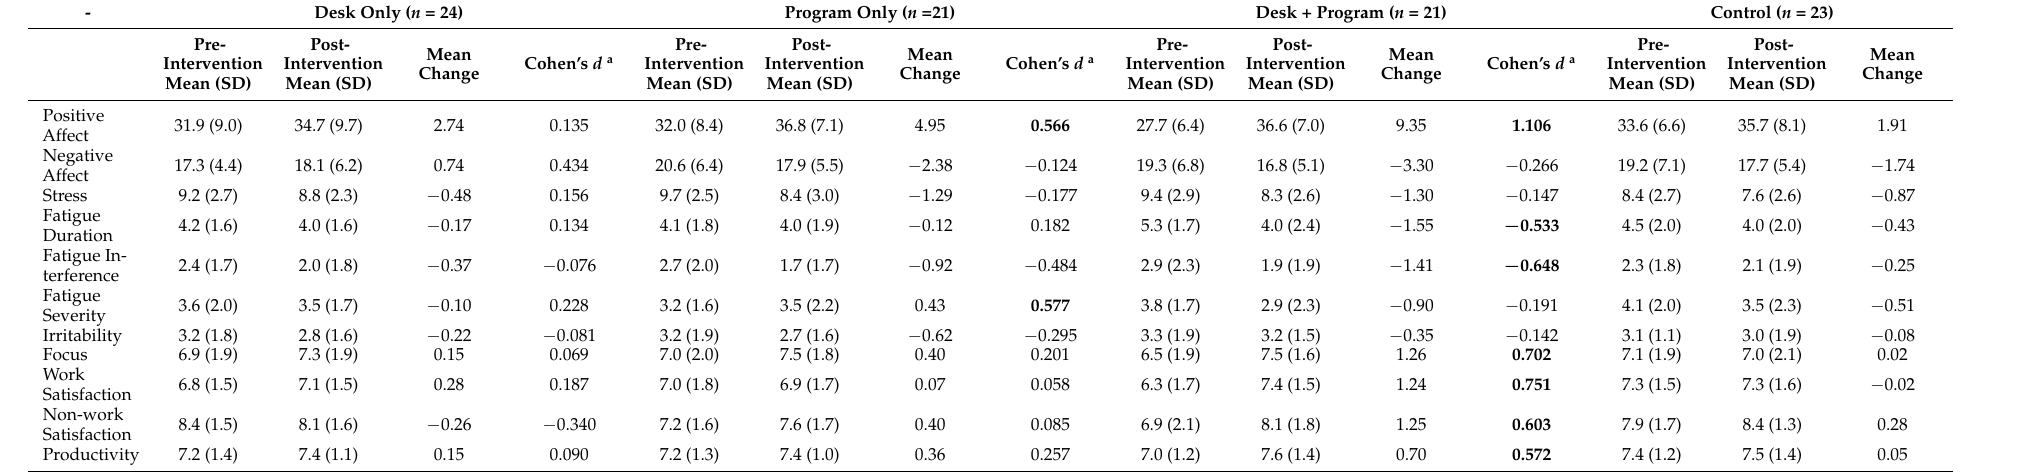
Table 2. Mean Change in Outcomes with Effect